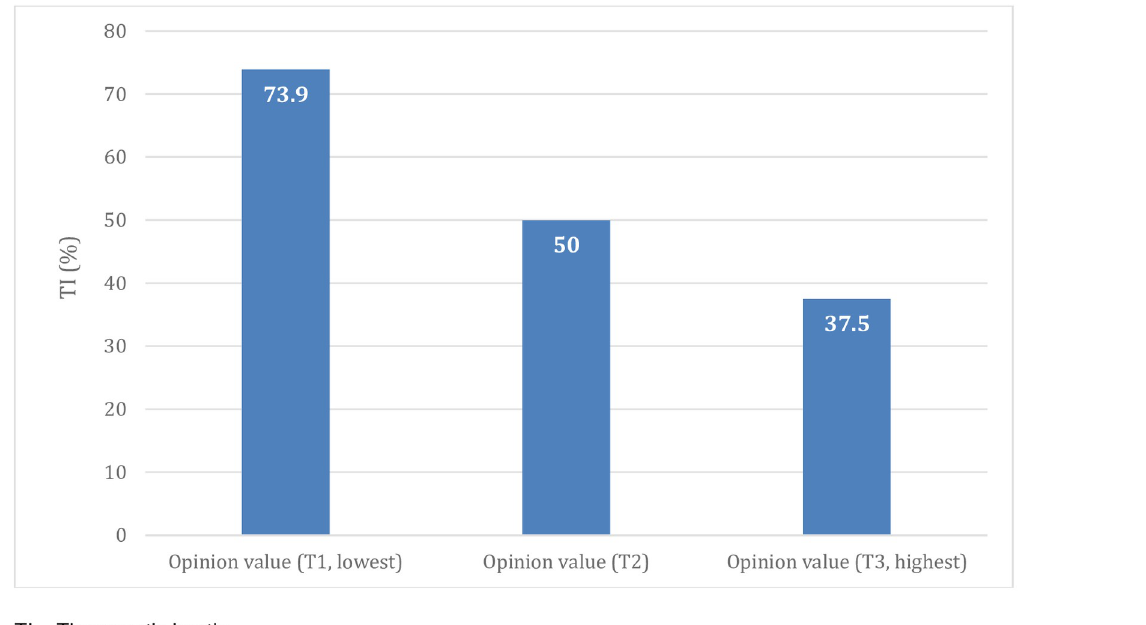
Fig 3. Frequency of therapeutic inertia by level of feeling of helpfulness in multiple sclerosis management.